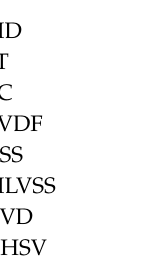
Figure S1: (a) Conductivity and (b) total nitrogen (TN) in the